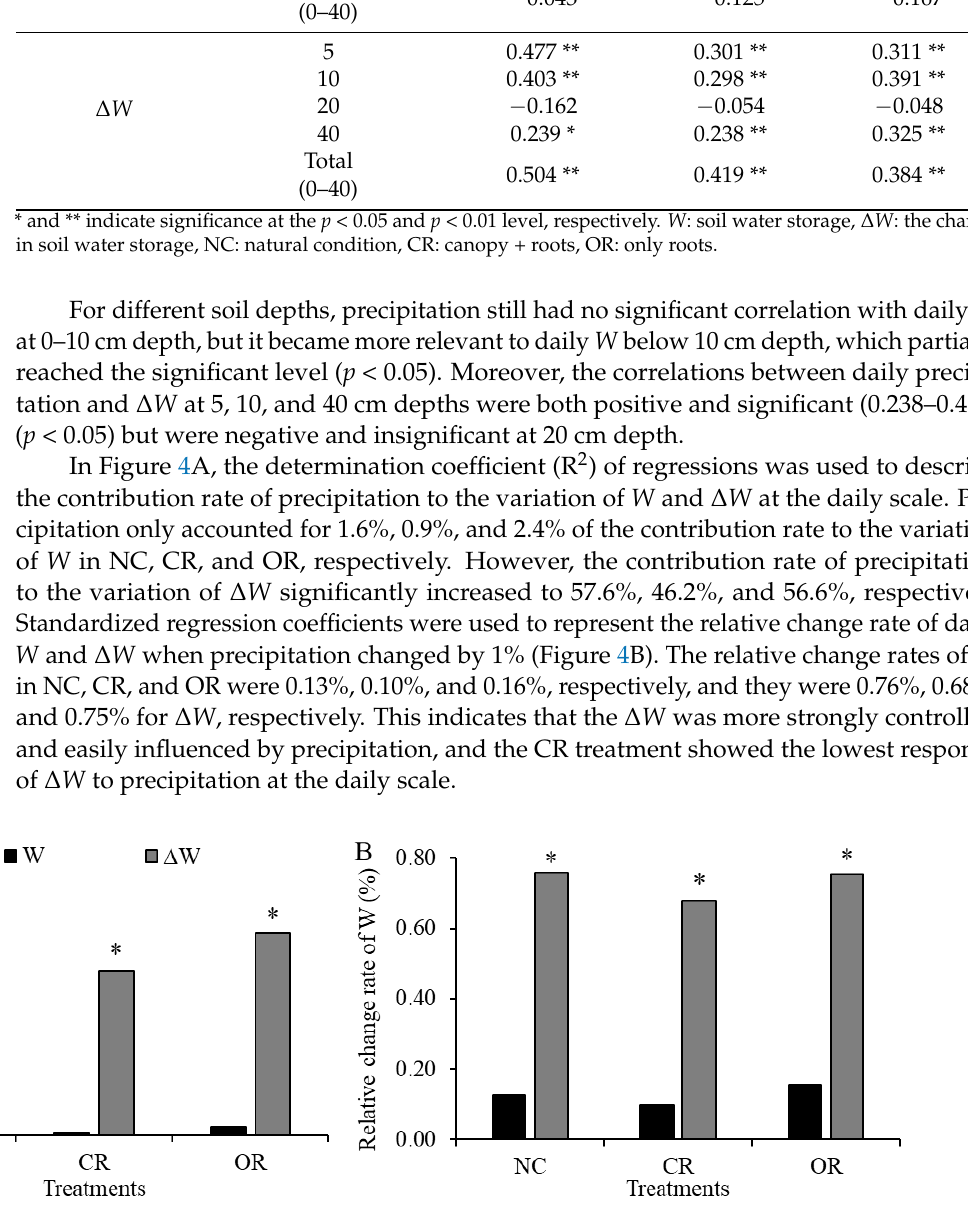
Table 1. The correlation between W and ∆ W of every day with precipitation during the rainy season. Indicators Soil Depths (cm) NC CR OR W 0.161